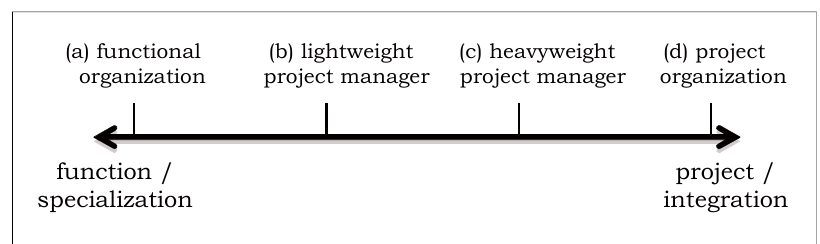
Figure 1. Function-project spectrum and organization